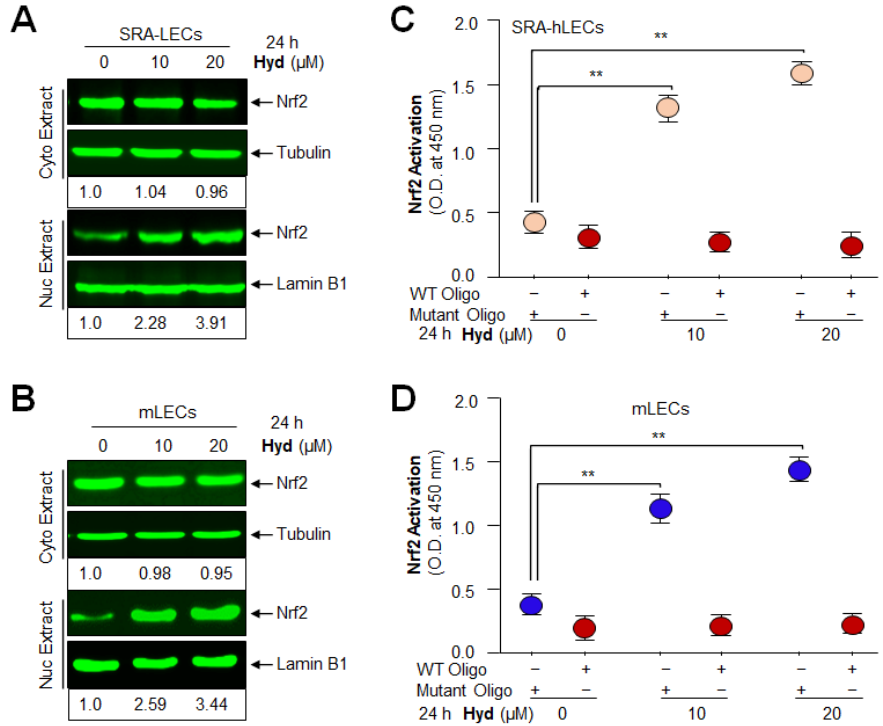
Figure 6. Hyd augmented the nuclear accumulation of Nrf2 and promoted the Nrf2/ARE activity in a dose-dependent manner. ( A , B ) Hyd induced increased nuclear accumulation of Nrf2 in LECs. Cultured SRA-hLECs ( A ) and mLECs ( B ) were treated with different concentrations of Hyd for 24 h. Cytosol and nuclear protein extract were immunoblotted with antibody specific to Nrf2. Tubulin and lamin B1 were used as loading control. Numbers under each protein band demonstrate densitometry value. ( C , D ) Hyd-treated LECs displayed significantly enhanced Nrf2 activity. Nuclear extracts from SRA-hLECs ( C ) and mLECs ( D ) treated with different amounts of Hyd for 24 h were analyzed for Nrf2/ARE interaction by ELISA (enzyme-linked immunosorbent assay). An equal amount of nuclear protein was processed and assayed for Nrf2 activity using a commercially available kit (Active motif). The data represent the mean ± S.D values from three independent experiments. p values were determined Hyd-treated vs. untreated control. ** p < 0.001.